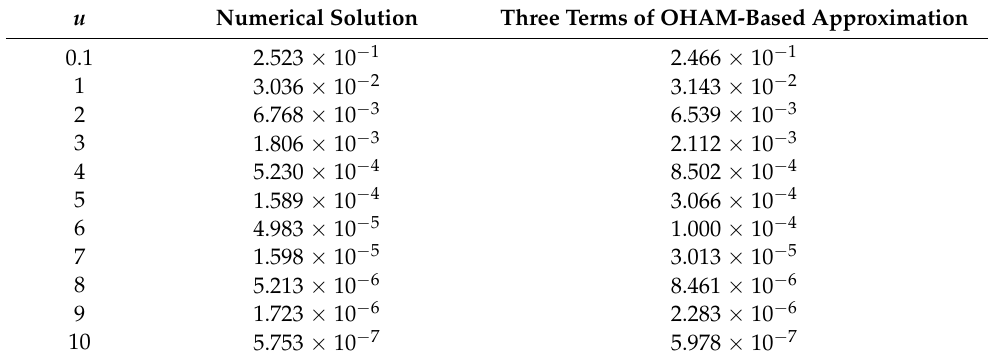
Figure 11. Flowchart for the OHAM solution (87). Table 4. Comparison between three terms of the OHAM-based approximation and Theis solution for the selected